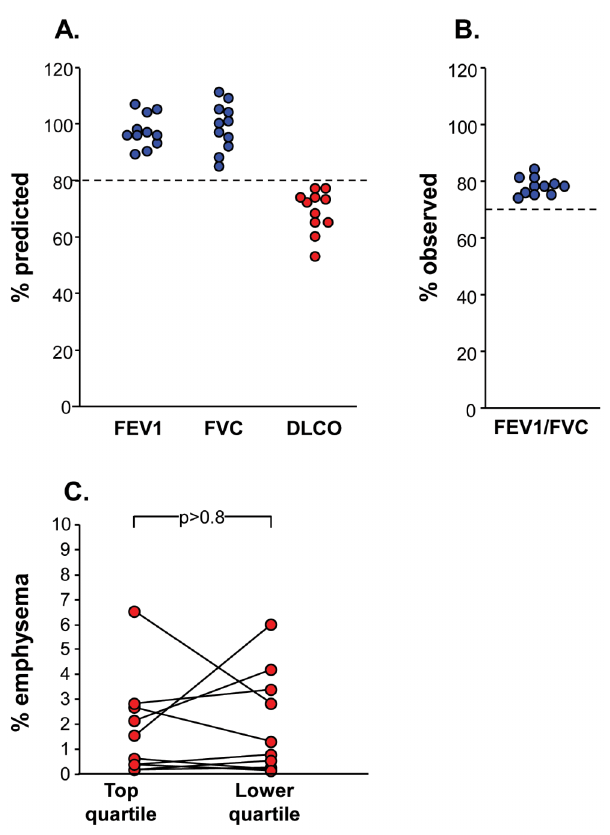
Figure 2. Lung function and chest high resolution computed tomography (HRCT) scans. A. Forced expiratory volume in 1 sec (FEV1), forced vital capacity (FVC), and diffusing capacity (DLCO), all as % predicted. B. Ratio of FEV1/FVC as % observed. C. HRCT quantification of emphysema by 2 950 Hounsfield Units (HU) divided into top (upper lung zones) and bottom (lower lung zones) quartiles by lung volume.